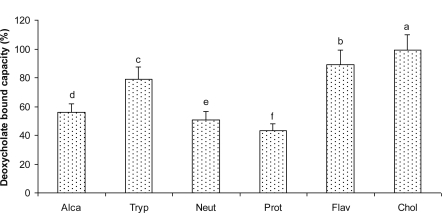
Sodium deoxycholate binding by peptides from five differents hydrolysates of defatted corn protein. Alca: Alcalase; Tryp: Trypsin; Neut: Neutrase; Prot: Protamex; Flav: Flavourzyme. Cholestyramine (Chol) was used as a positive control. Different letters indicate significant differences (p < 0.05).